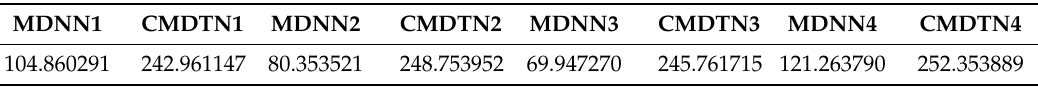
Table 13. The runtime of incomplete data fault diagnosis model without and with transfer learning in o ffl ine. (unit: